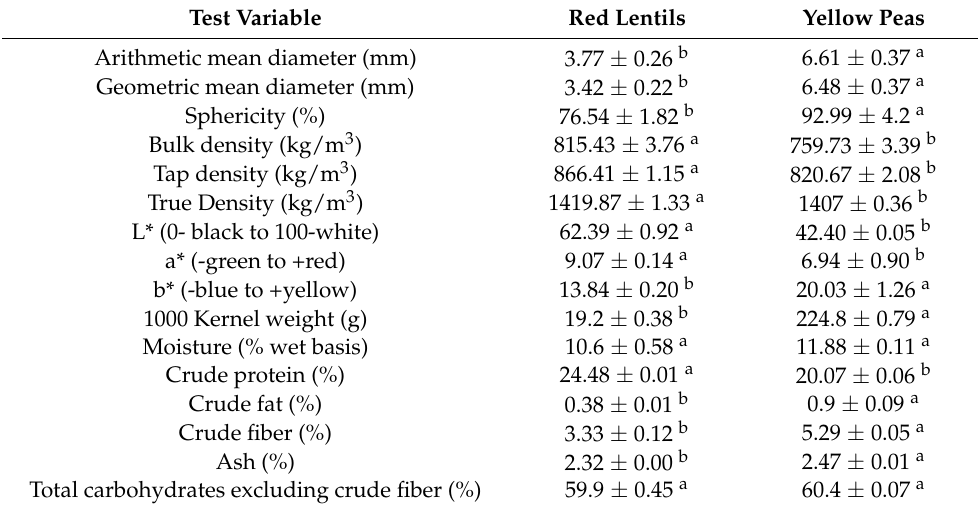
Table 1. Physicochemical properties of pulses. Test